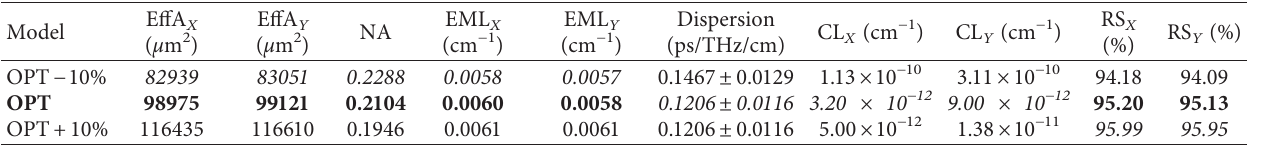
Table 2: Comparison of the optical parameters for the three model sat